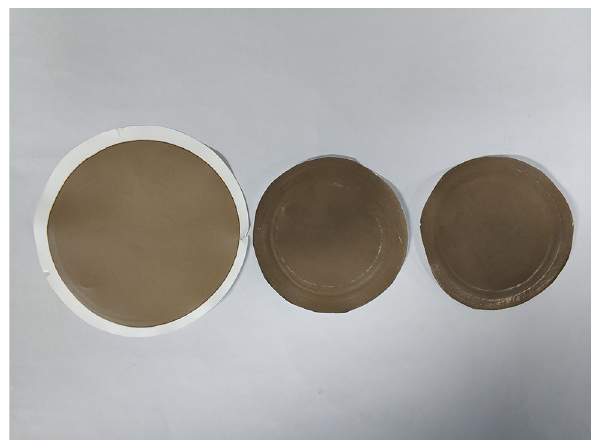
Fig. 10 Digital photographs of c-GO-PEI membranes before (left) and after test with 6.36 ppb (center) and 9.4 ppb (right) Hg-contain- ing wastewaters that washed with DI